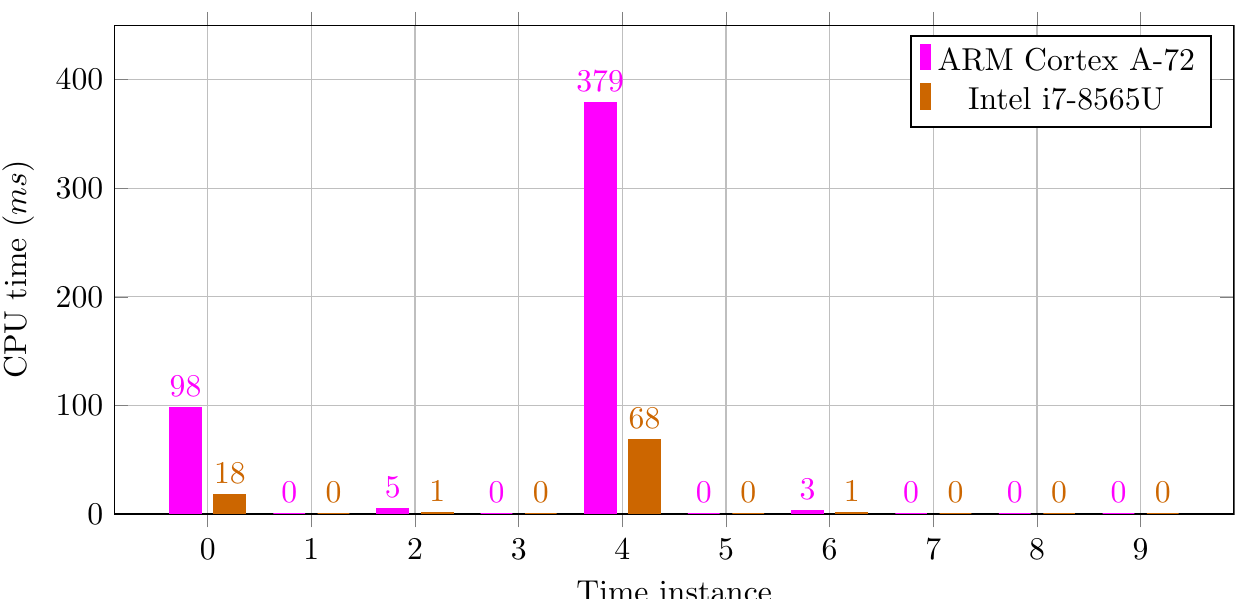
Figure 7. Evaluated vertices from the reachability graph throughout the simulation. As far as the required processing capabilities are concerned, the utilized CPU time was measured. The Traffic Controller service was executed on two different hardware platforms, an ARM-based embedded board (ARM Cortex-A72 (ARM Inc., Cambridge, UK) running at 1.5 GHz) and on an x86 personal computer (Intel i7-8565U (Intel Inc., Santa Clara, CA, USA) CPU running up to 4.60 GHz). Figure 8 shows the employed CPU time for the computation of the AGV trajectories throughout the simulation in both hardware platforms. It has to be noted that these measurements may vary depending on the selected programming language and/or employed technology. The Traffic Controller service was implemented in Ada. This programming language is widely used in the safety domain [39], as well as for the development of air traffic management systems [41].